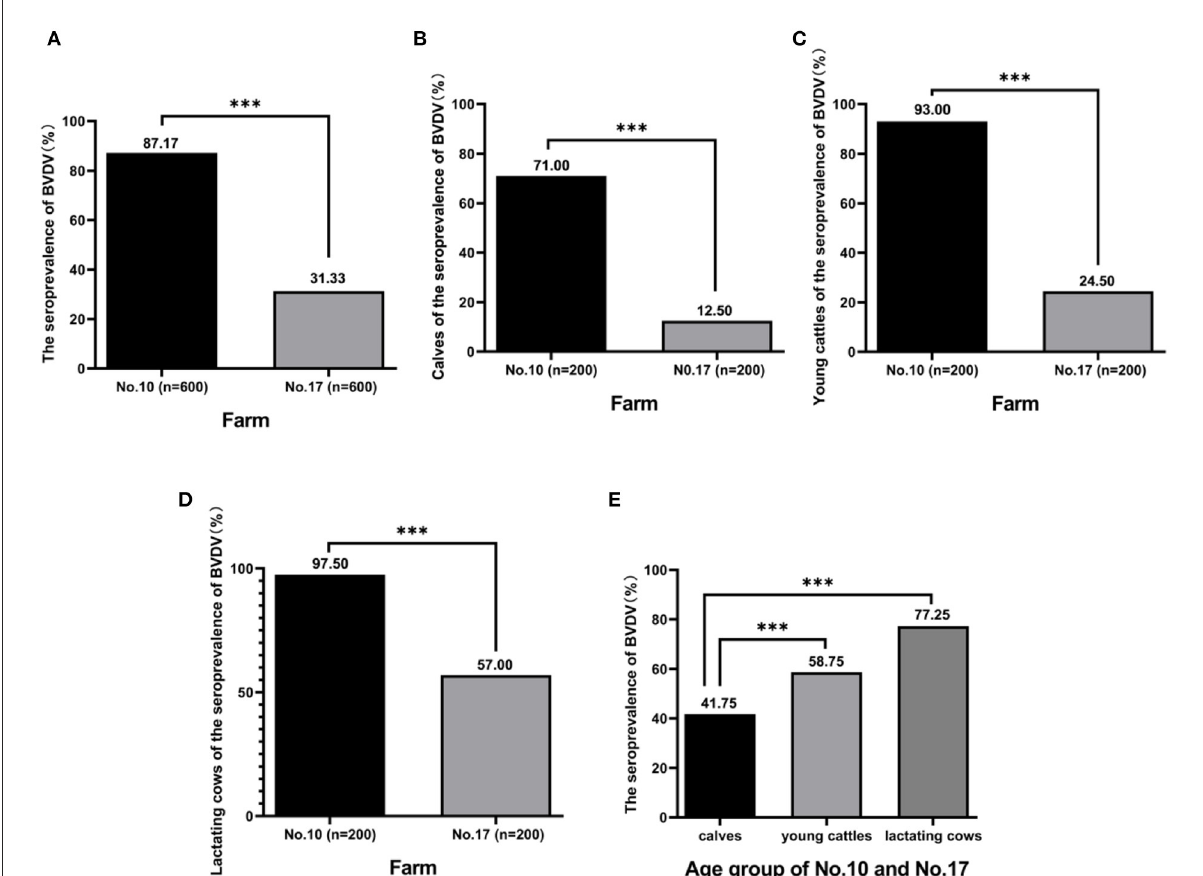
FIGURE2 The seroprevalence of BVDV in individual animals. A total of 1,200 blood samples were collected from farm No. 10 and farm No. 17 including calves, young cattle, and lactating cows, and antibody against BVDV was detected by BVDV Antibody Detection Kit. The seroprevalence of BVDV in two farms was analyzed (A) , rate of calves was analyzed (B) , rate of young cattle was analyzed (C) , rate of lactating cows was analyzed (D) , and rate of calves, young cattle, and lactating cows was analyzed, respectively (E) . *** Indicates P <